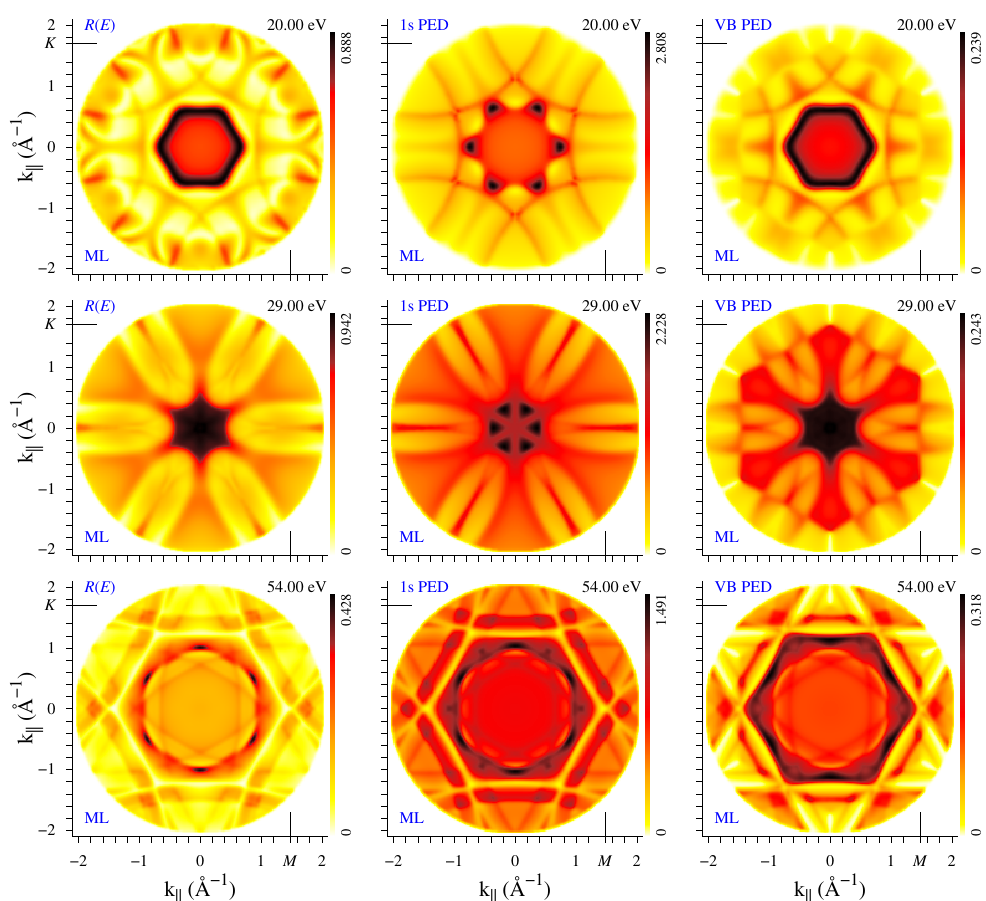
Figure 2. Electron diffraction from the monolayer graphene. Constant energy k || distribution of the specular reflectivity R , photocurrent from the C 1 s core states I 1 s , and from the highly dispersive lowermost band I VB are shown in the 1st, 2nd, and 3rd columns, respectively. Three energies are presented: 20, 29, and 54 eV in the 1st, 2nd, and 3rd rows, respectively. The Γ M line is placed horizontally. The value at the top of the color scale bar indicates the map maximum, which presents the fraction of the specularly reflected current in the R maps, and arbitrary units in the I maps (the same units in all I maps). The full movie for E = 5 to 59 eV can be found at film1-MLRCV.mov . The electron diffraction maps from the AB bilayer are presented in Figure 3 for the same three energies. The bilayer bears C 3 v symmetry, and thus the PED maps naturally do not exhibit vertical-mirror symmetry axis. At the same time, the R ( k || ) maps show C 6 v symmetry, which is the consequence of 3D inversion symmetry of the bilayer. Indeed, one can prove (see Appendix A) that the transmission and reflection coefficients, t and r